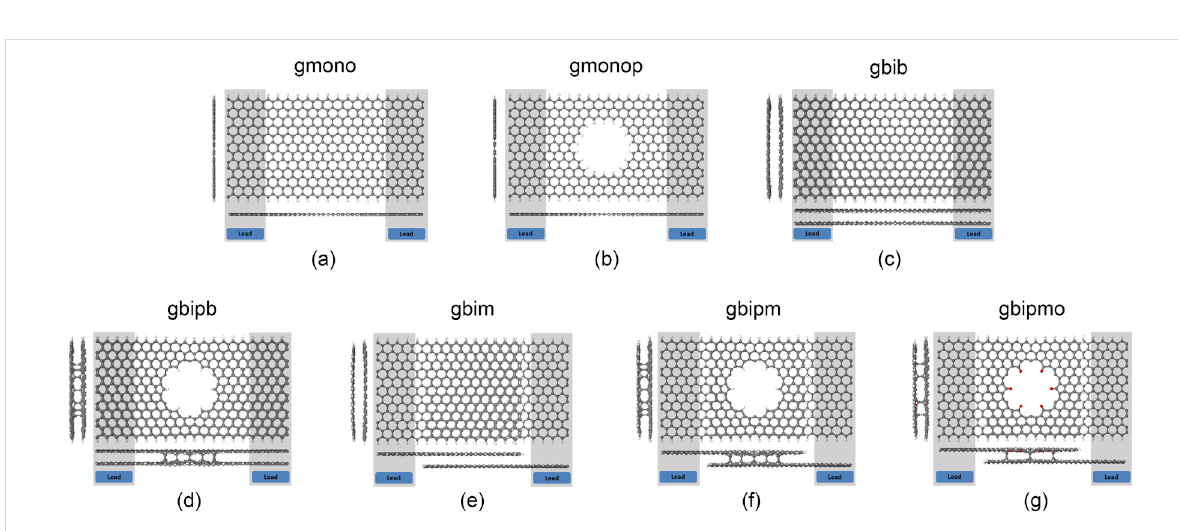
Figure 1: Geometry of the graphene-based structures, (a) monolayer graphene ribbon, (b) monolayer graphene nanopore, (c) AA-bilayer graphene ribbon, (d) engineered bilayer graphene nanopore, (e) AA-bilayer graphene with monolayer lead, (f) engineered bilayer graphene nanopore with monolayer lead and hydrogen termination inside the pore, (g) engineered bilayer graphene nanopore with monolayer lead and oxygen termination inside the